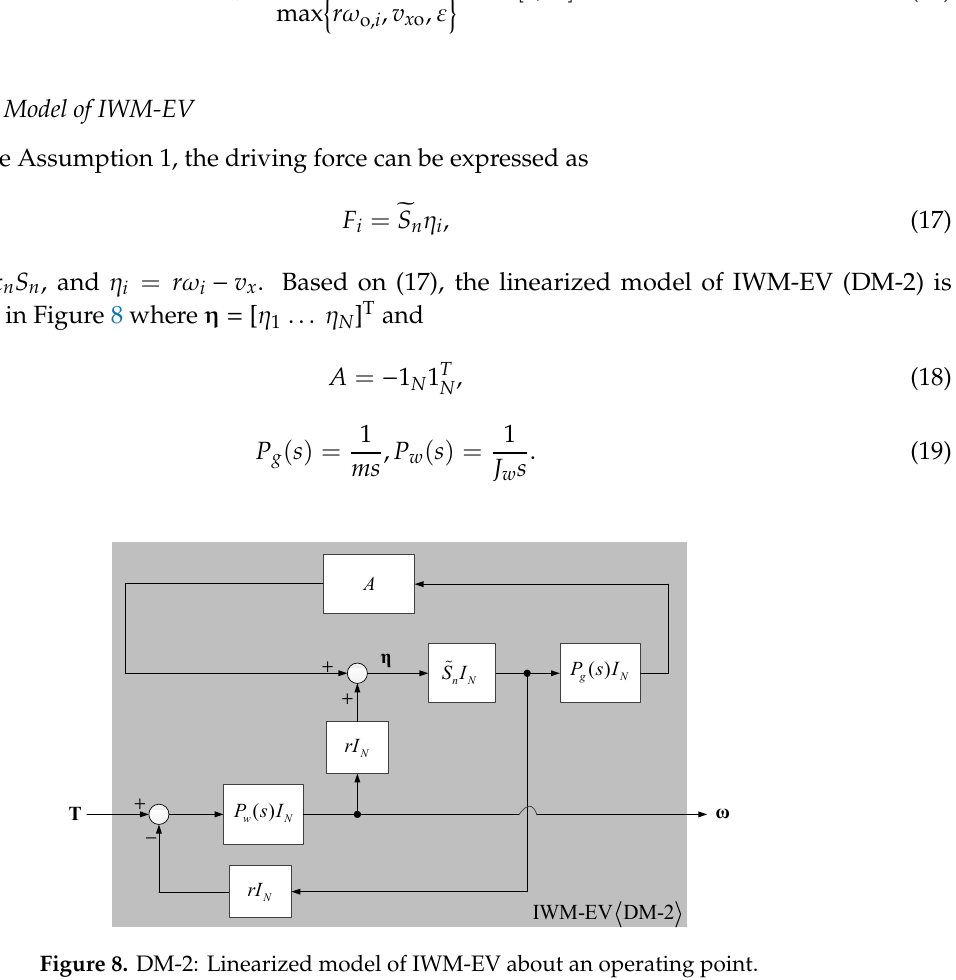
Figure 8. DM-2: Linearized model of IWM-EV about an operating point.